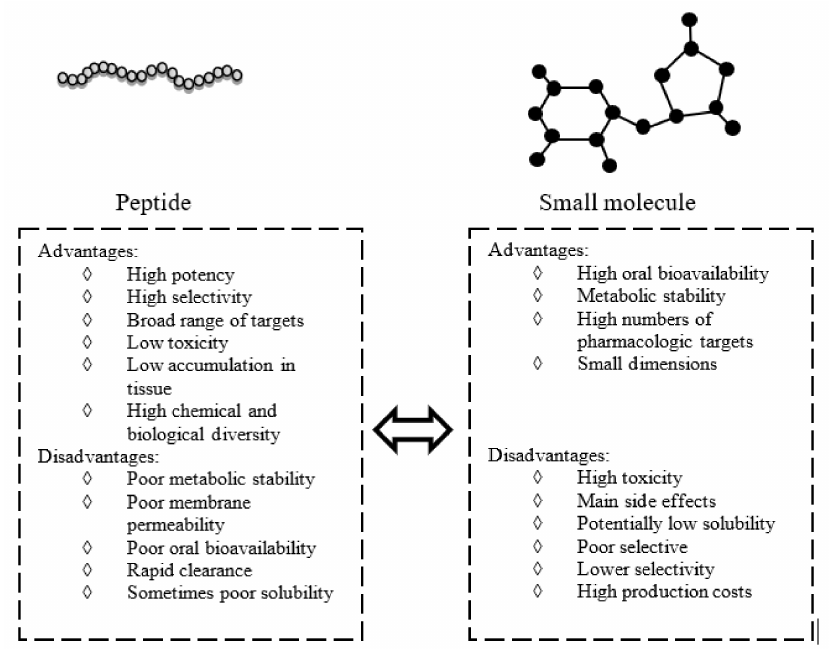
Figure 1. Peptides versus small molecules: advantages and